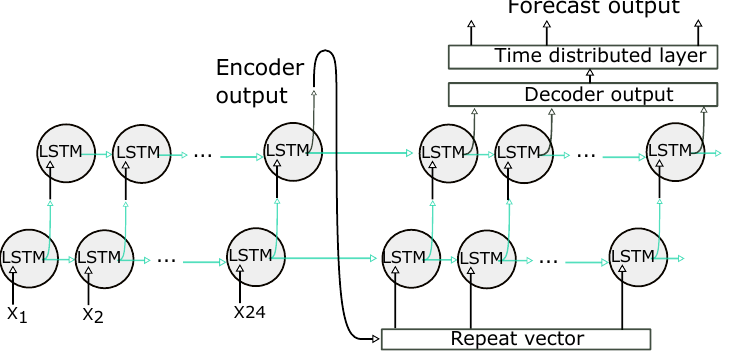
Figure 11. LSTM Encoder Decoder